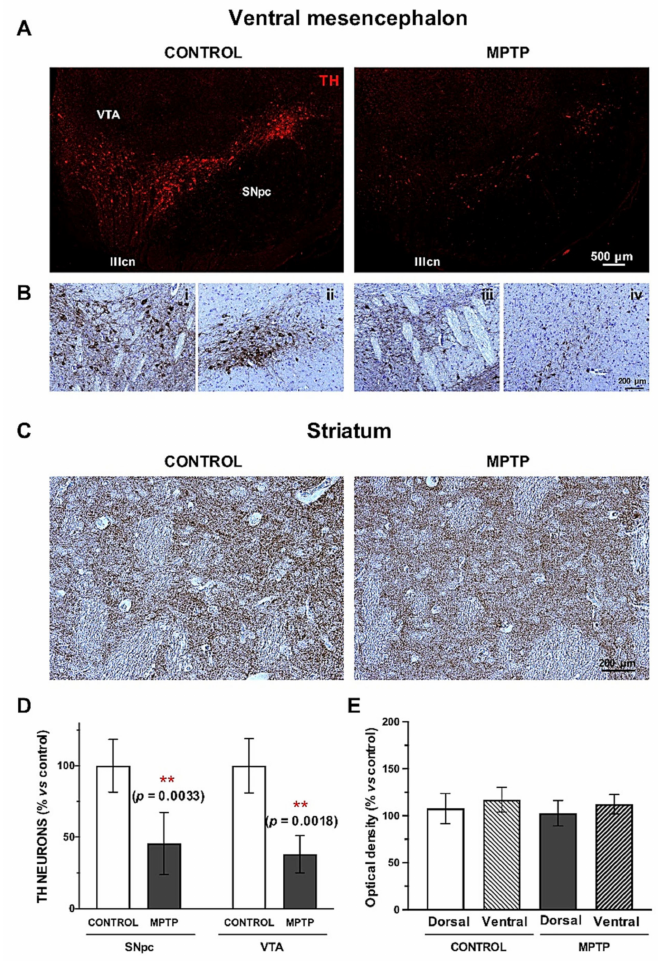
Figure 4. The dopaminergic pathway is compromised in the O. degus after chronic intoxication with MPTP. ( A ) Representative microphotographs of TH immunostaining performed in the ventral mesencephalon (SNpc and VTA) of control and MPTP animals. ( B ) TH immunohistochemistry counterstained with Nissl at the level of the exit of the third cranial nerve in VTA and lateral SNpc of control (i, ii) and MPTP animals (iii, iv). ( C ) Representative microphotographs TH immunostaining in the striatum of control and MPTP animals. ( D ) Quantification of TH+ neurons in the SNpc and in the VTA. ( E ) Optical density quantification of TH+ terminals by in the striatum. Data are expressed as mean ± SD; ** p < 0.01. SNpc = Substantia Nigra pars compacta; VTA = ventral tegmental area; IIIcn = exit of the third cranial